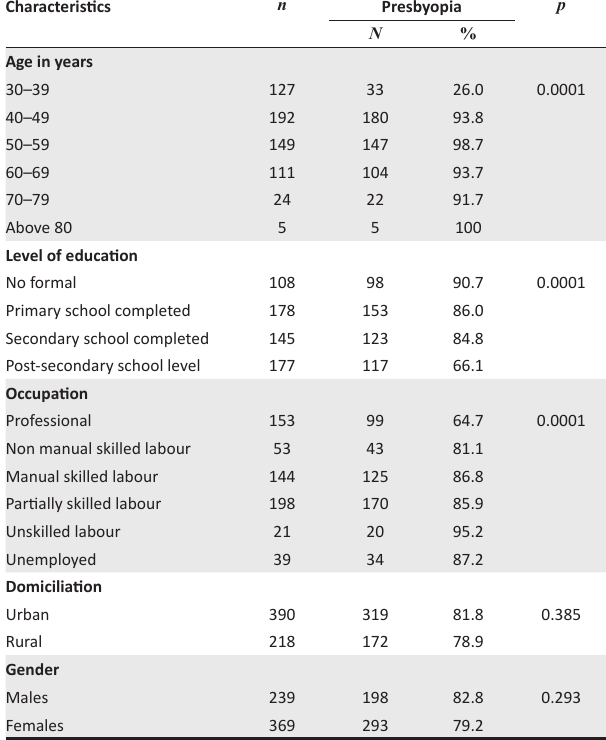
TABLE 2: Associations between presbyopia and socio-demographic factors in the 491 study participants who were presbyopic. Characteristics